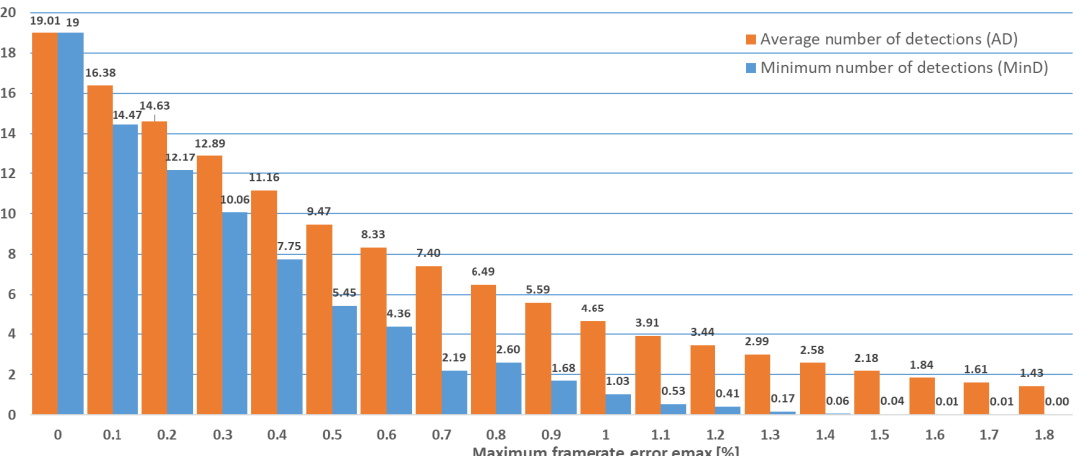
Table 1. Statistical analysis of the ADT and MaxDT (120 frames per second case). m a x e